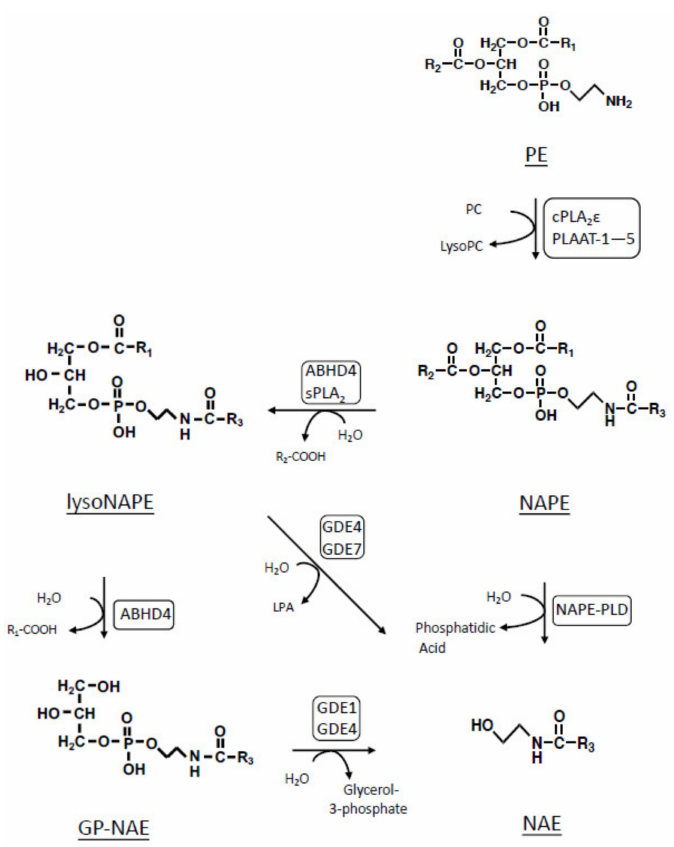
Figure 1. Biosynthetic pathways of NAE in mammals. PLAAT: phospholipase A and acyltransferase.